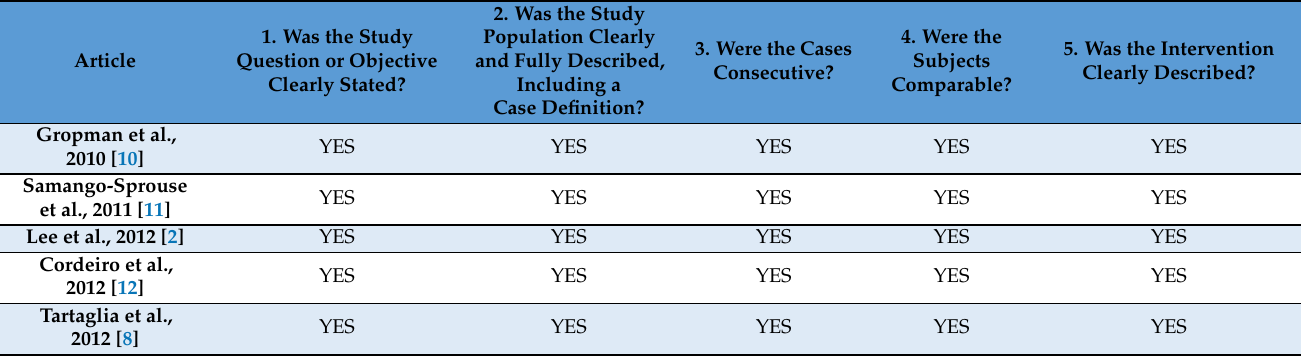
Table 1. Quality